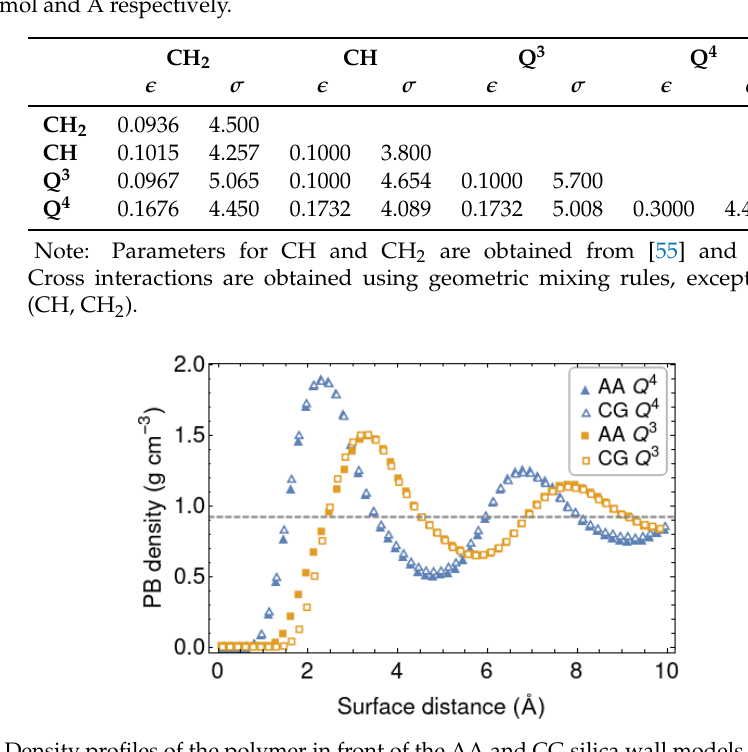
Figure 3. Density profiles of the polymer in front of the AA and CG silica wall models at 298 K, for two silica surface models. The average density at the center of the slab is shown with a dashed